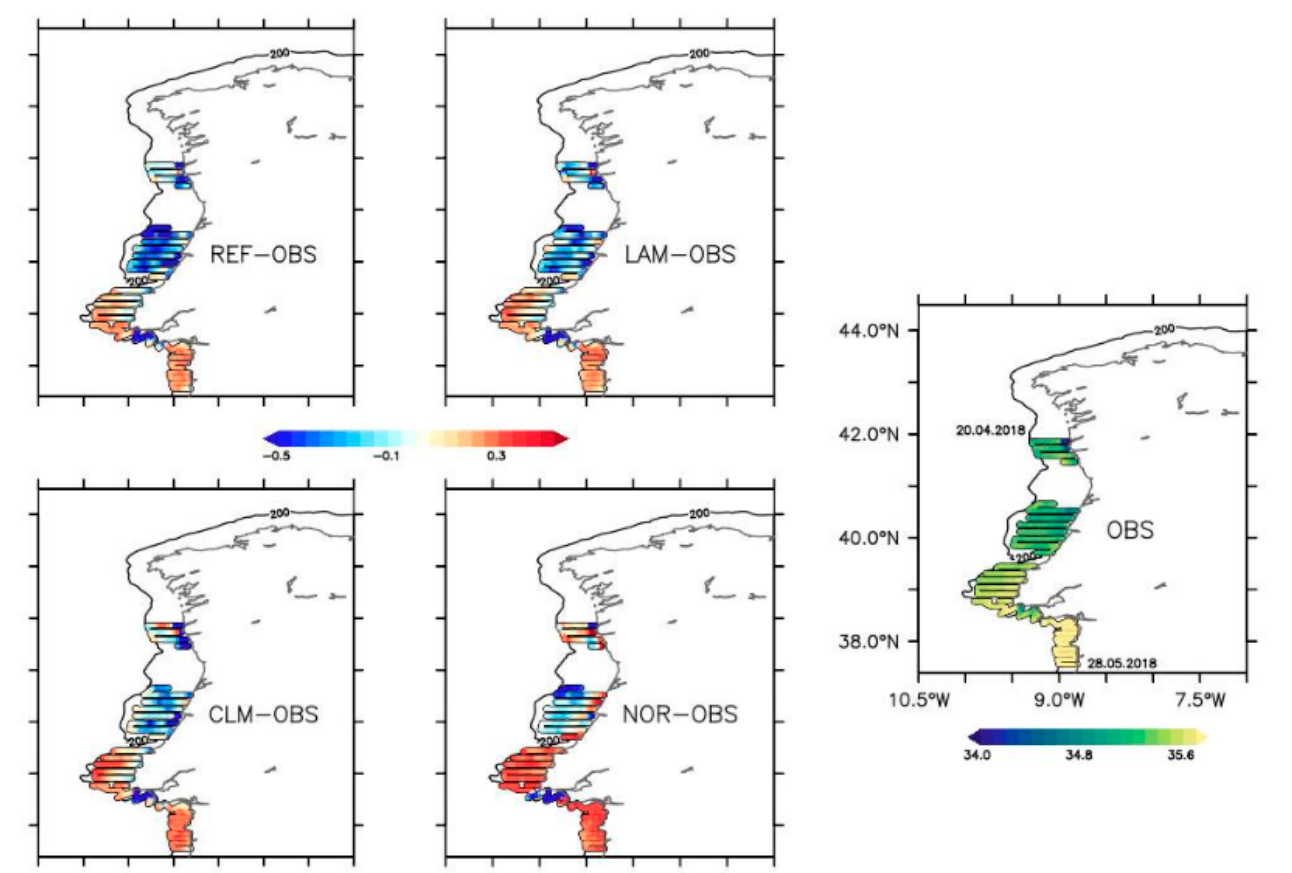
Figure 11. Surface salinity during the IPMA campaign in May 2018 in WISHE area. The right panel shows observed (OBS) salinity (measured by means of a thermo-salinometer), and the rest of the panels (from left to right) show differences between modelled salinities (from IBI_REF, IBI_LAM, IBI_NOR, IBI_CLM model scenarios) and the observations.